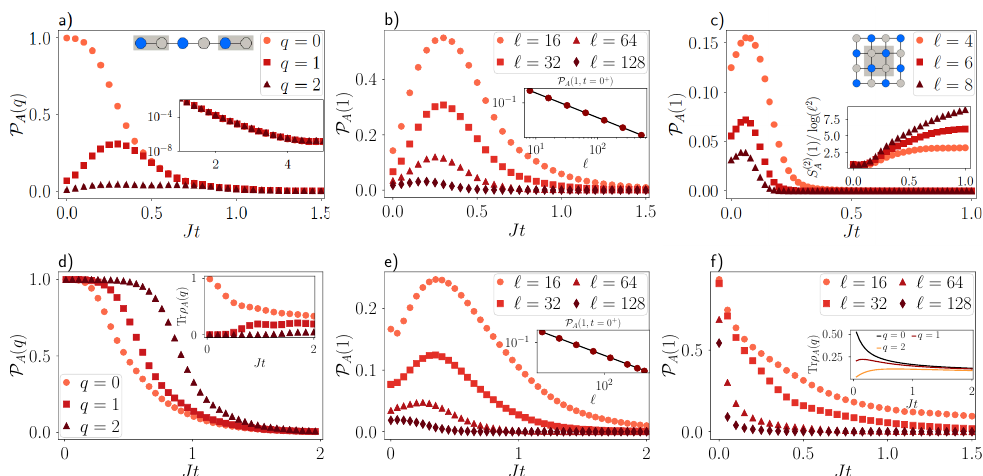
( (cid:96)/ 2 + q ) for a quadratic open fermionic Figure 7: Results of the simulation of P A system. We omit (cid:96)/ 2 and use q = q − (cid:96)/ 2 to label the symmetry sectors. Parameters: J = 1, µ = 0. First line: symmetry-resolved Rényi entropy for a) 1D system with L = 64, l = 32, γ = 0.05; b) 1D system for L = 2 (cid:96) , q = 1, γ = 0.05; c) 2D system with L = 4 (cid:96) , N = L 2 , q = 1, γ = 0.2. Second line: symmetry-resolved Rényi entropy for d) 1D system with L = 64, l = 16, γ = 0, purely coherent dynamics; e) 1D system for L = 2 (cid:96) , q = 1, γ = 0.05, starting from the Majumdar-Ghosh dimer state; f)1D system for L = 2 (cid:96) , q = 1, γ = 0.05, starting from the ground state of a nearest- neighbours tight binding model with J =